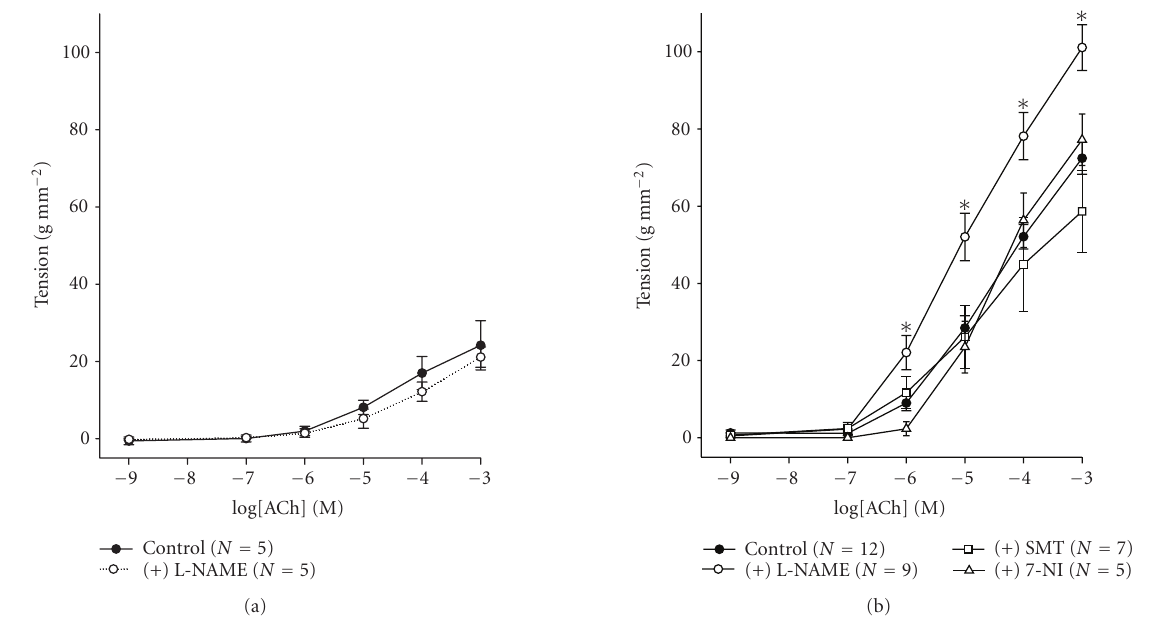
Figure 2: (a) Concentration-e ff ect curves for acetylcholine at 0.5g RT and normal extracellular calcium concentration, in the absence or in the presence of L-NAME. Data are means from 5 experiments and vertical lines show SE. (b) Concentration-e ff ect curves for acetylcholine at 2.5 g RT and normal extracellular calcium concentration, in the absence or in the presence of the nonselective inhibitor of NOS, N G -nitro- L -arginine methyl ester (L-NAME), the inhibitor of iNOS, S-methylsothiourea (SMT), and nNOS, 7-Nitroindazole (7-NI). Data are means of 5 to 12 experiments and vertical lines show SE. N refers to the number of animals studied. ∗ P < . 05 compared to control values.